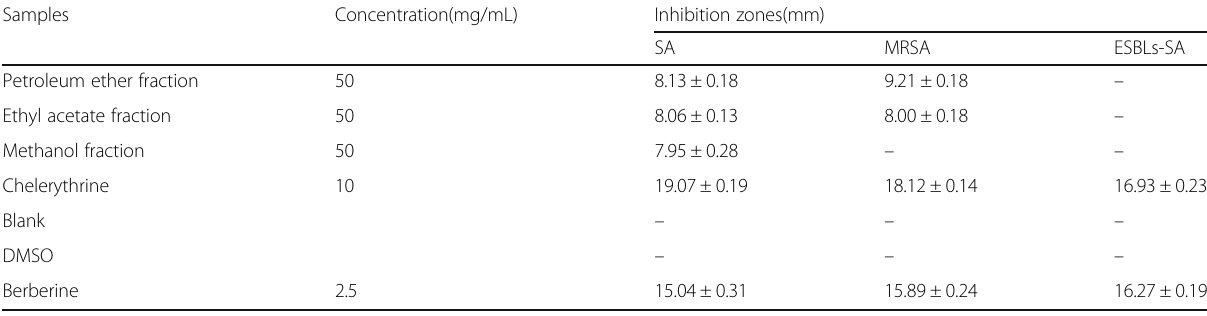
Table 2 Inhibition zones of antimicrobial activity of T. asiatica fractions and Chelerythrine